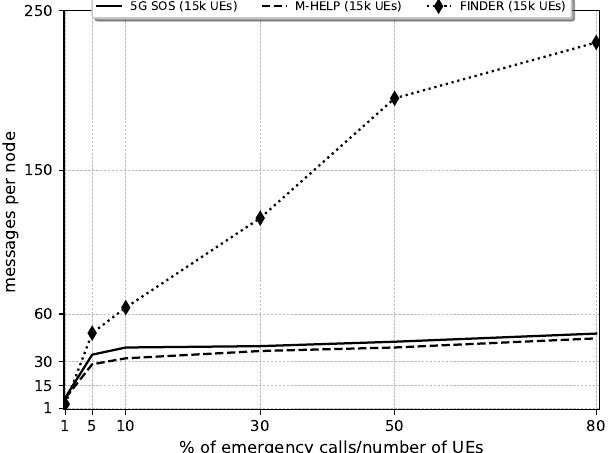
Figure 16. Comparison of the number of messages per node against the ratio of the number of emer- gency calls (NEC) to the number of UEs (NoU) under 5G-SOS, M-HELP, and FINDER. Parameters: NoU: NEC: 1% of NoU to 80% of NoU, NoU: 15,000 UEs, ETI: 1800 s (30